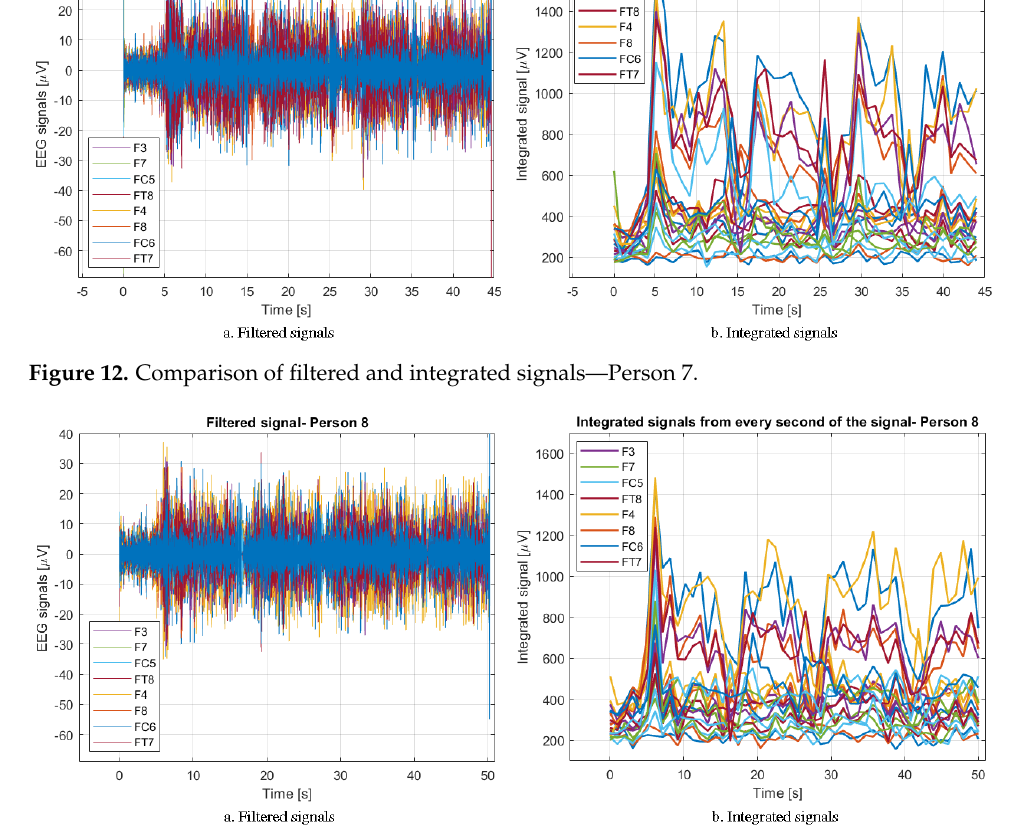
Figure 13. Comparison of filtered and integrated signals—Person 8.